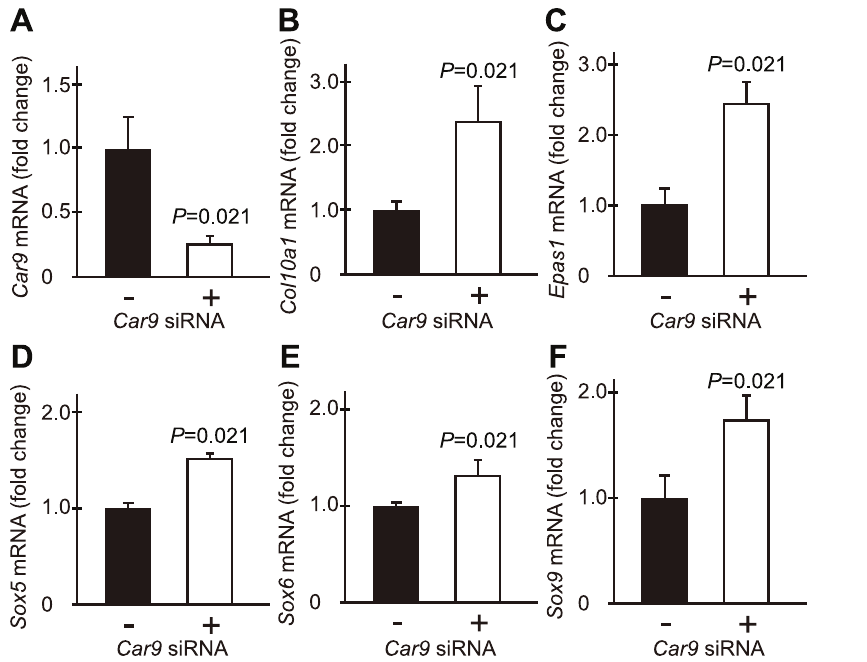
Figure 5. Effects of Car9 siRNA on the expressions of transcription factors related to chondrocyte differentiation in primary chondrocytes cultured under a hypoxic condition. Car9 siRNA ( + ) or control siRNA (-) was introduced into mouse primary chondrocytes under a hypoxic condition (5% CO 2 and 95% N 2 ). The cells were additionally cultured for 48 hours under the same condition. The expressions of Car9 , Col10a1 , Epas1 , Sox5 , Sox6 , and Sox9 were quantitatively analyzed by real-time RT-PCR. The expression level of each gene was normalized to that of Gapdh . Data are expressed as the mean 6 SD (n=4) in the fold change by introduction of Car9 siRNA. P -values determined by two-tailed Mann- Whitney U-test are